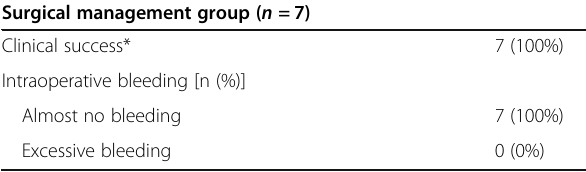
Table 4 Prevention effect of intraoperative bleeding after TAE Surgical management group ( n =